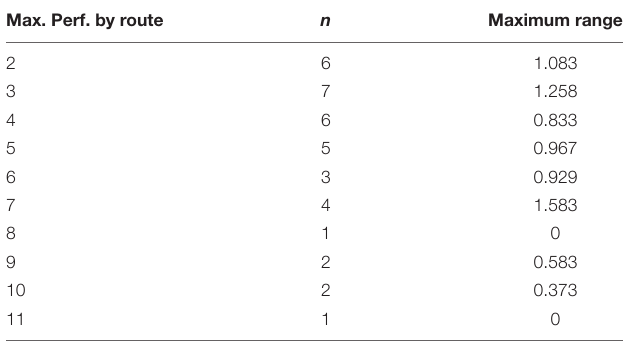
TABLE 3 | Maximum range values of phenotypic plasticity for different maximum performance (Max. Perf.) by route. Max. Perf. by